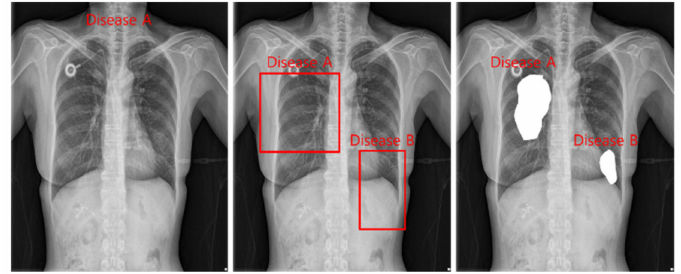
Figure 2. Classification, detection, and segmentation